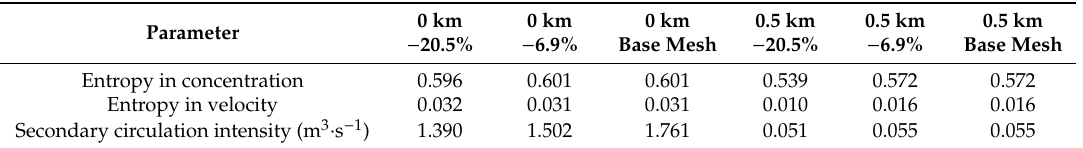
Table 2. Tests of sensitivity of the entropy statistics and secondary circulation (see Equations (22) and (23)) to mesh resolution for two cross-sections using the R